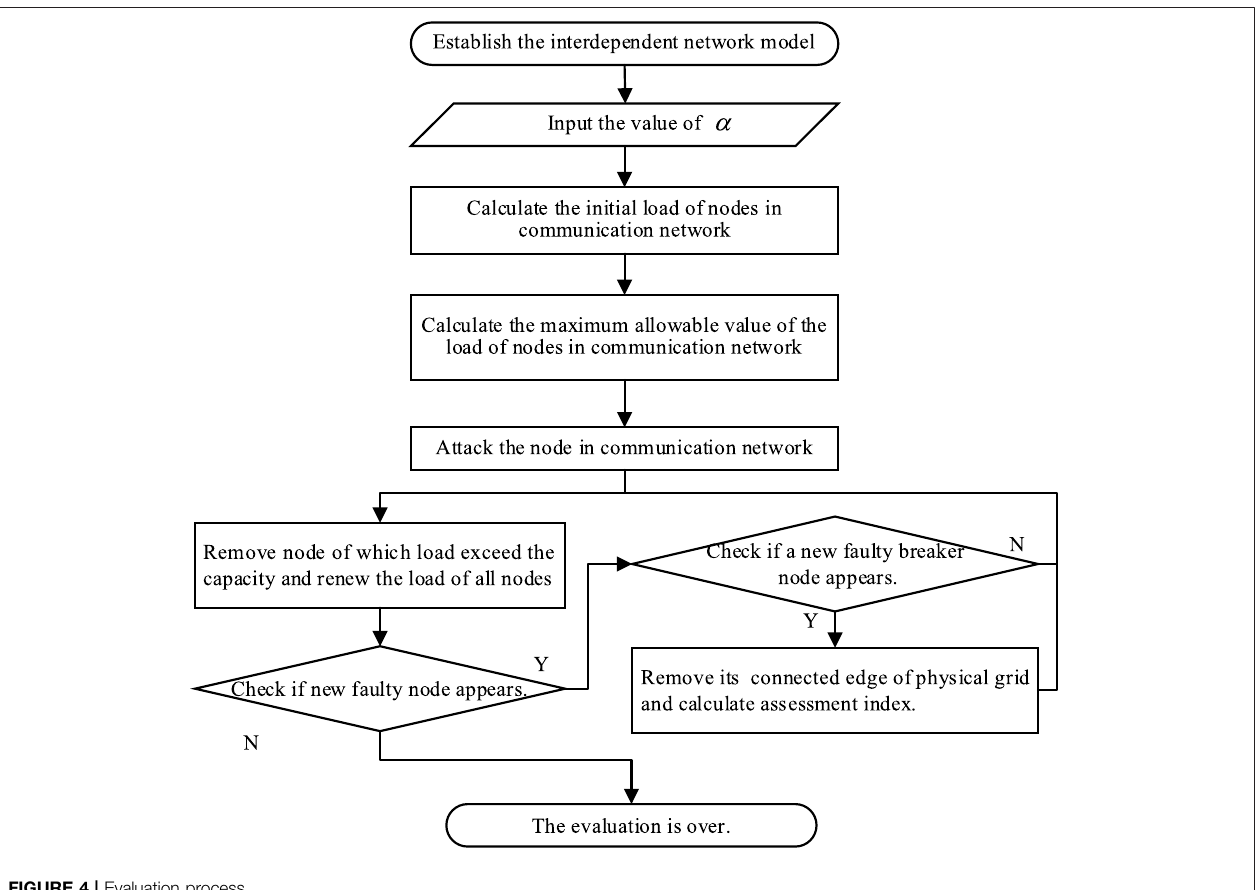
FIGURE 4 | Evaluation